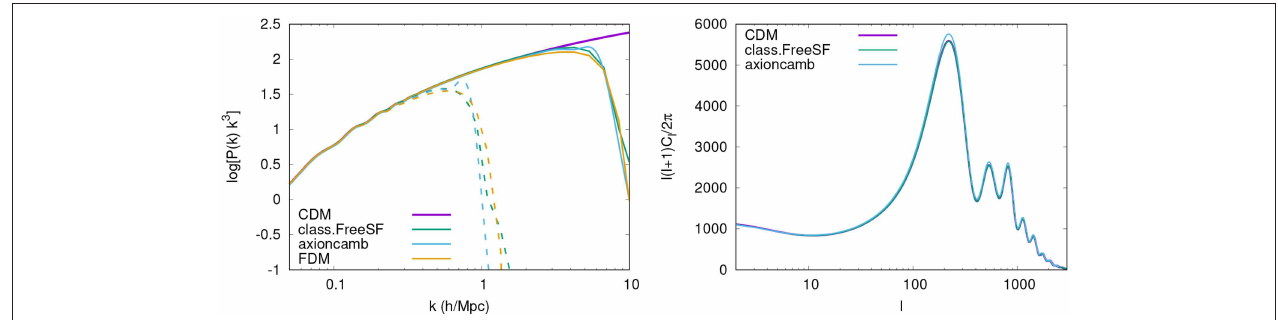
FIGURE 2 | The MPS (Left) and the anisotropies of the CMB (Right) obtained for the SFDM model from the amended Boltzmann codes CLASS.FreeSF and axioncamb. As explained in section 2.2, the code CLASS.FreeSF solves the polar form of the perturbed KG equation (10), whereas axioncamb solves its equivalent fluid form. In general, SFDM looks indistinguishable from CDM, although there are some small discrepancies in the outputs generated by the Boltzmann